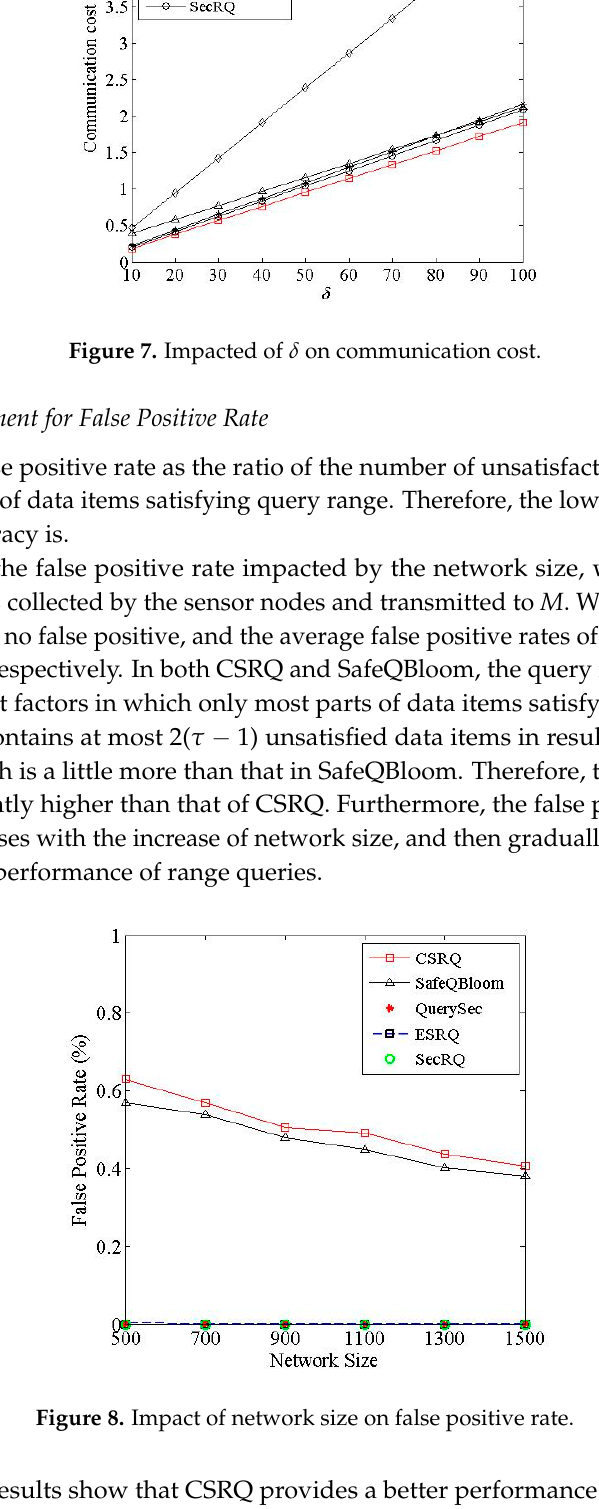
15 of 18 Figure 6. Impact of l e on communication cost.